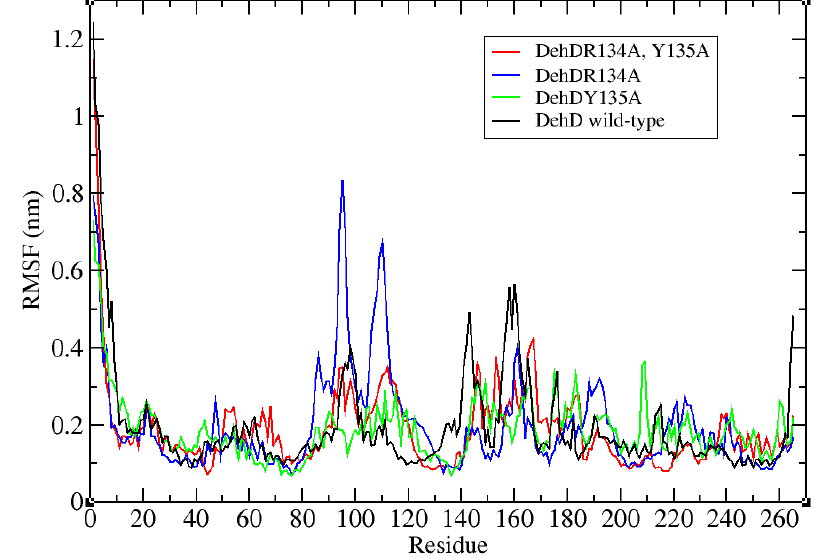
Figure 6. RMS fluctuations of amino acid residues of DehD compared to its variants. ( i ) black is wild-type DehD. ( ii ) blue is the R134A mutant. ( iii ) green is the Y135A mutant. ( iv ) red is the double substitution R134A/Y135A